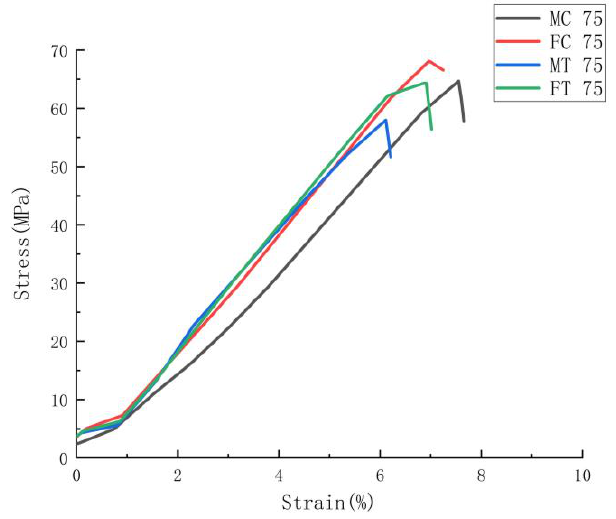
Figure 9. Average stress-strain curves for HT series samples with joint configurations.